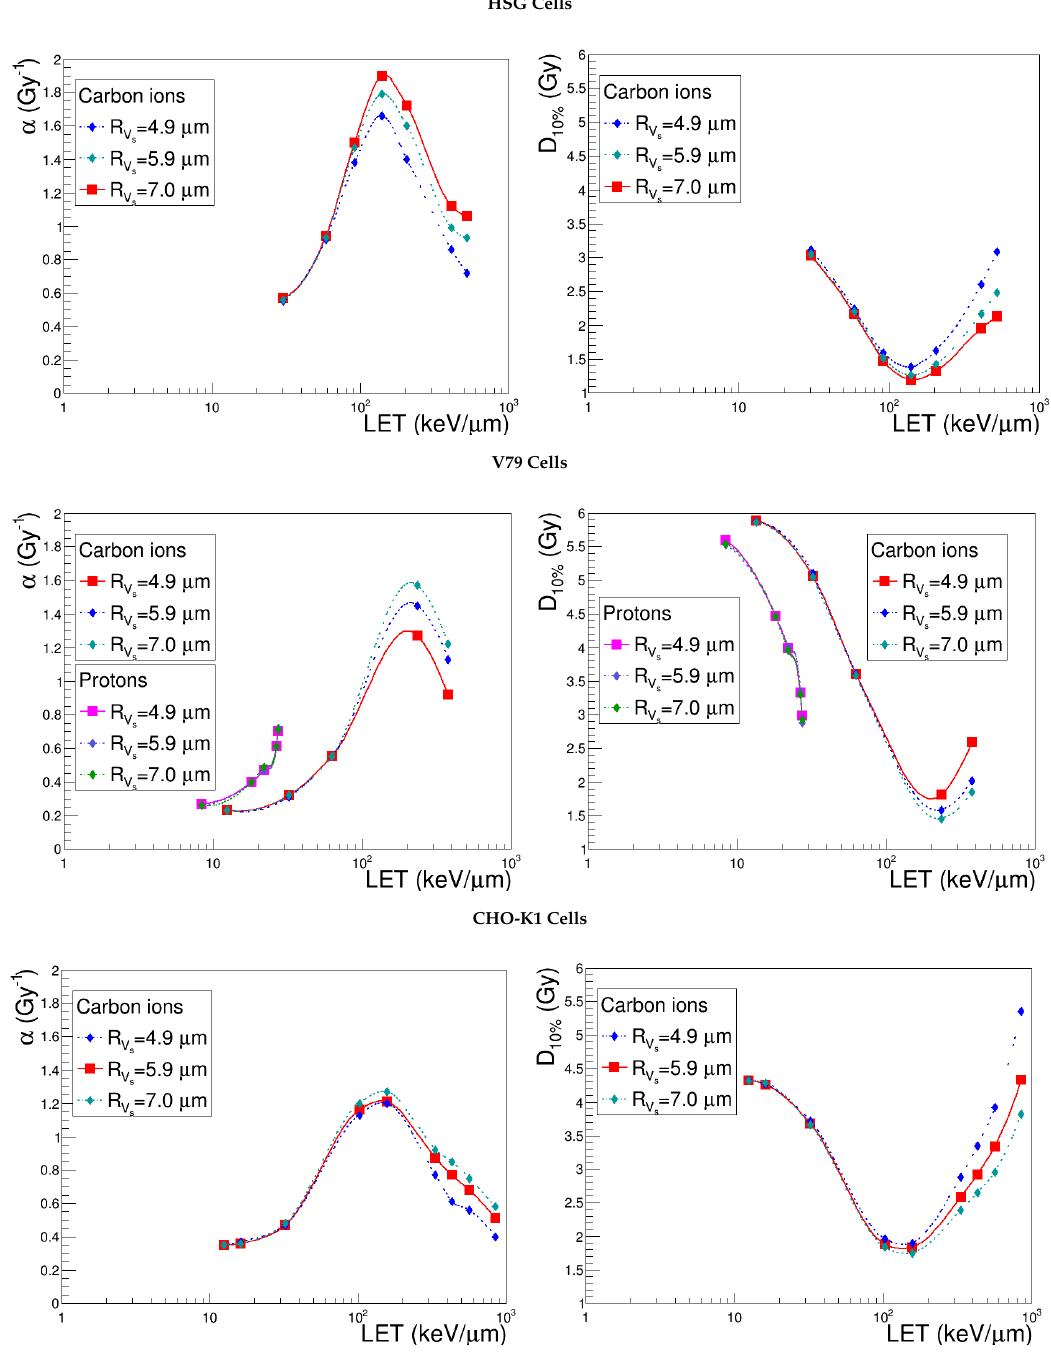
Figure 3. α and D 10% predicted by NanOx for the standard configuration (red curve) and for the varied sensitive volume radii (blue and light blue curves) keeping a constant thickness, as detailed in Table 2. The full symbols correspond to the LET values for which the estimates were performed, while the lines are drawn just to guide the eye and do not represent a